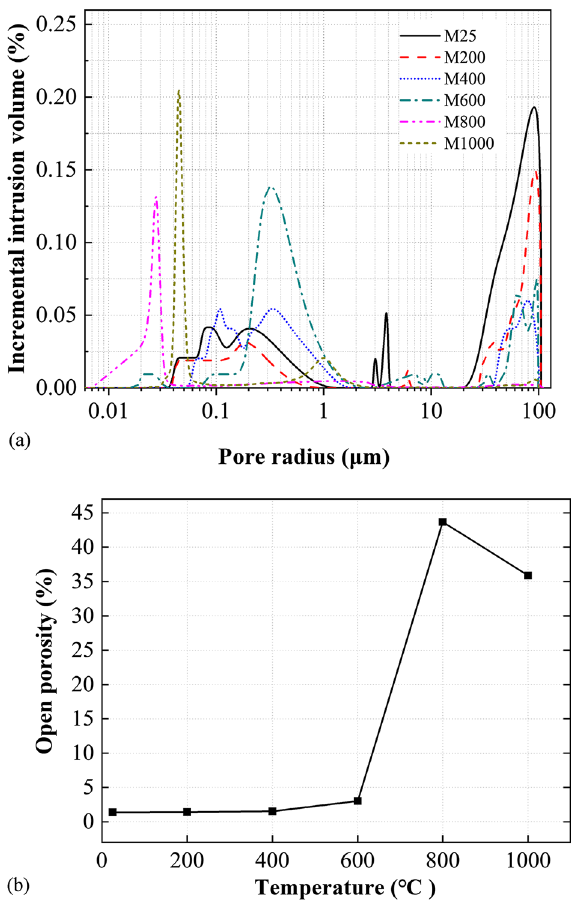
Figure 1. ( a ) Pore size distribution and ( b ) open porosity of marble samples exposed to different